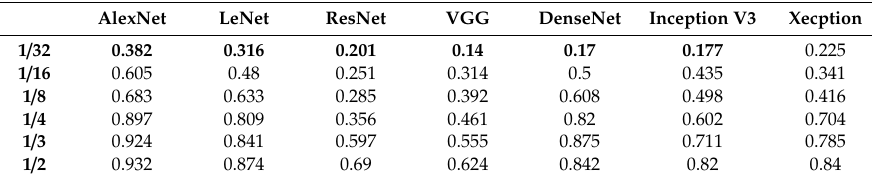
Table 15. Experiments under small established datasets on SOC.